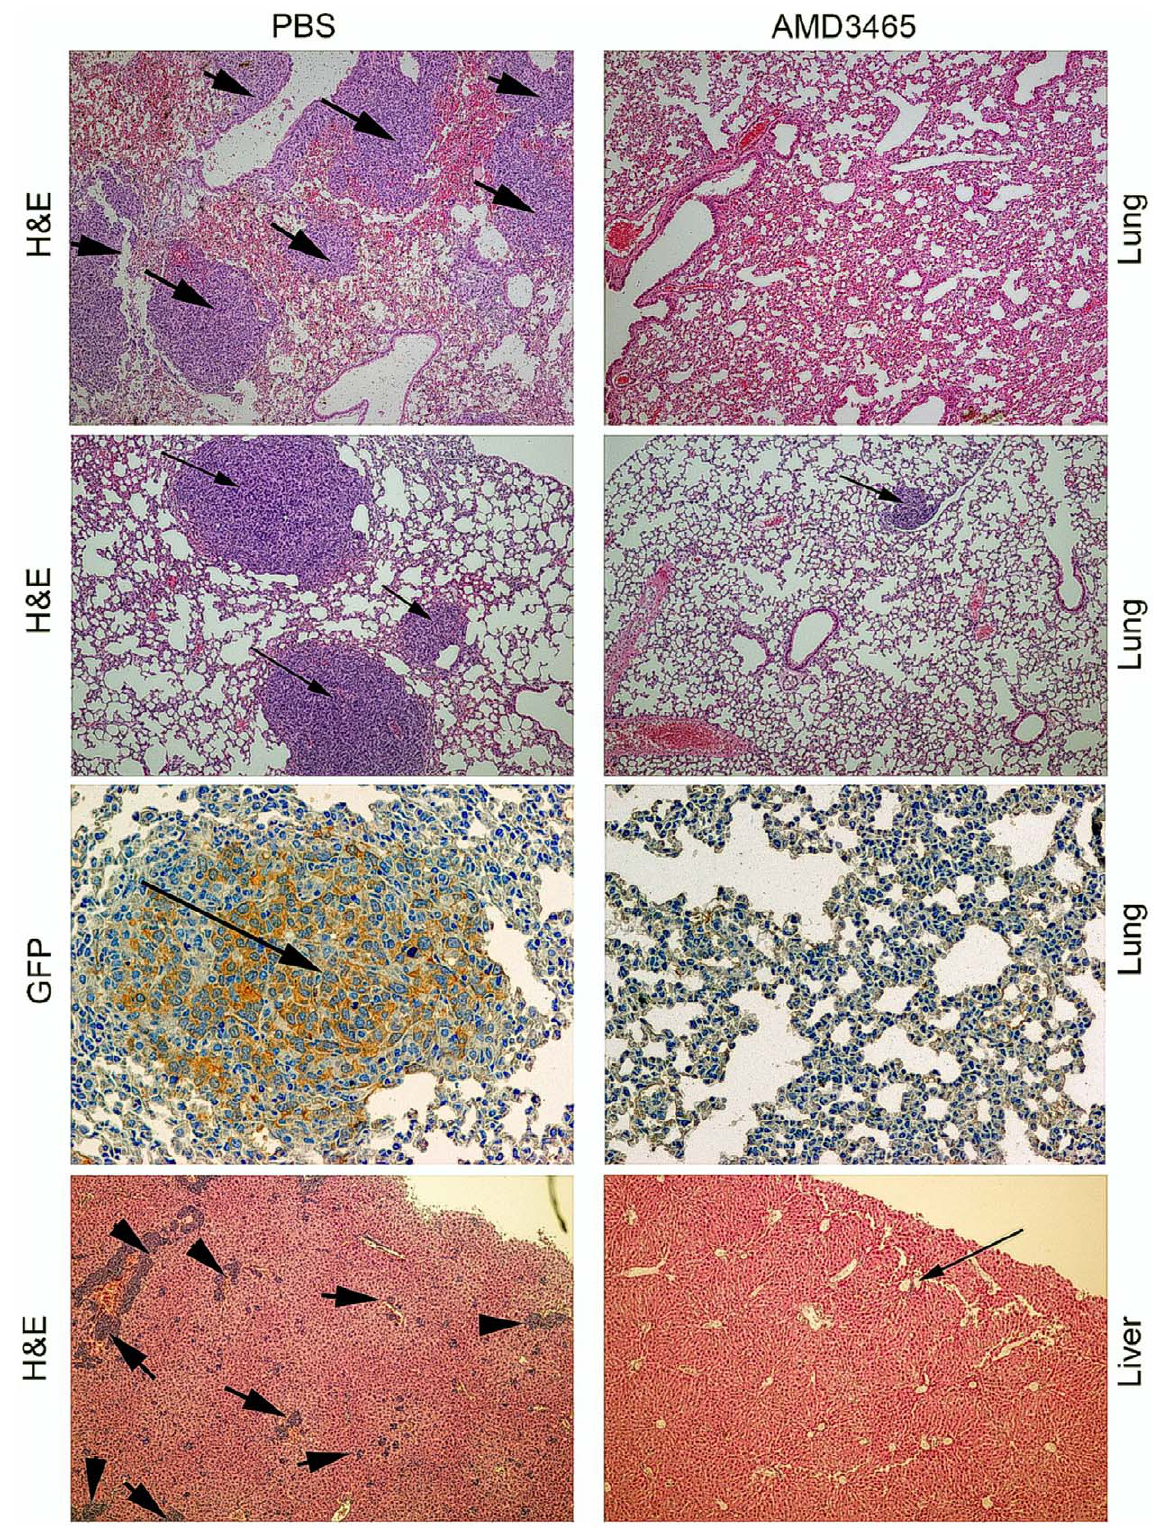
Figure 4. AMD3465 reduces tumor metastases in a syngenic breast cancer model. The size/number (indicated by arrows) of metastatic nodules in the 4T1 tumor bearing mice treated with PBS (control) or AMD3465 in both the lung and liver as determined by H&E staining. We also confirmed the metastatic nodules were GFP positive as were the primary tumors. A detailed treatment procedure for the metastasis assay is described in the Method section.